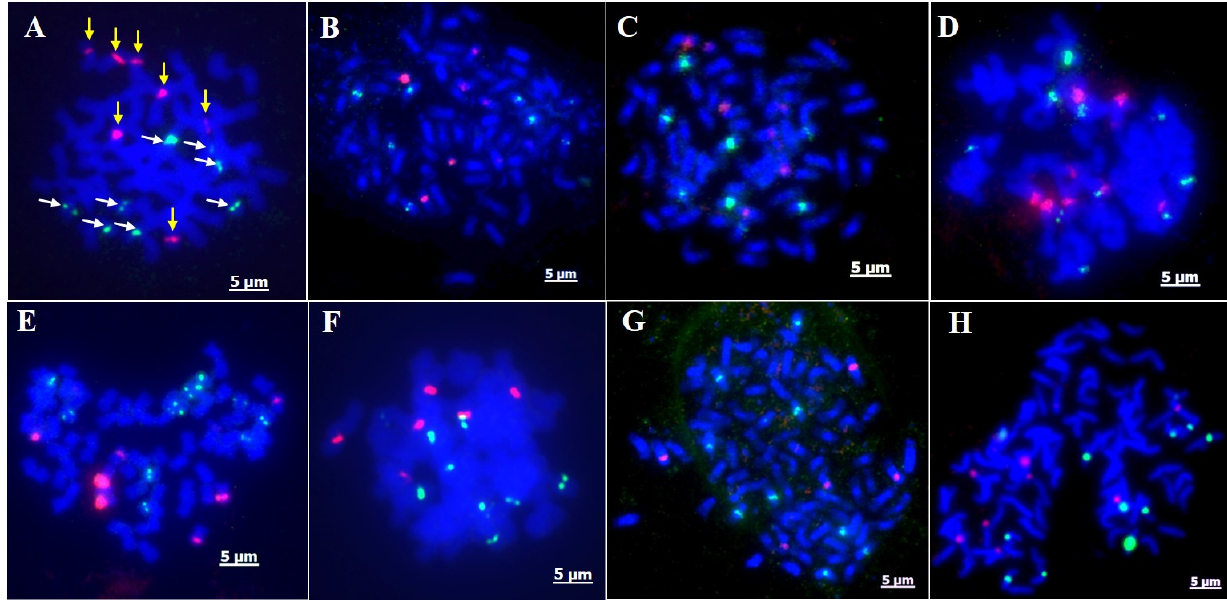
Figure 6. Localization of 5S rDNA and 35S rDNA probes on root – tip metaphase chromosomes of S. spontaneum by FISH. ( A – H ): SES208; Yunnan82 ‐ 63; Yunnan83 ‐ 160; Sichuan92 ‐ 42; Yunnan82 ‐ 50; Yunnan82 ‐ 114; Yunnan83 ‐ 171; Guizhou78 ‐ 2 ‐ 28, respectively. The 5S rDNA signals are green and indicated by white arrows. The 35S rDNA signals are red and indicated by yellow arrows.